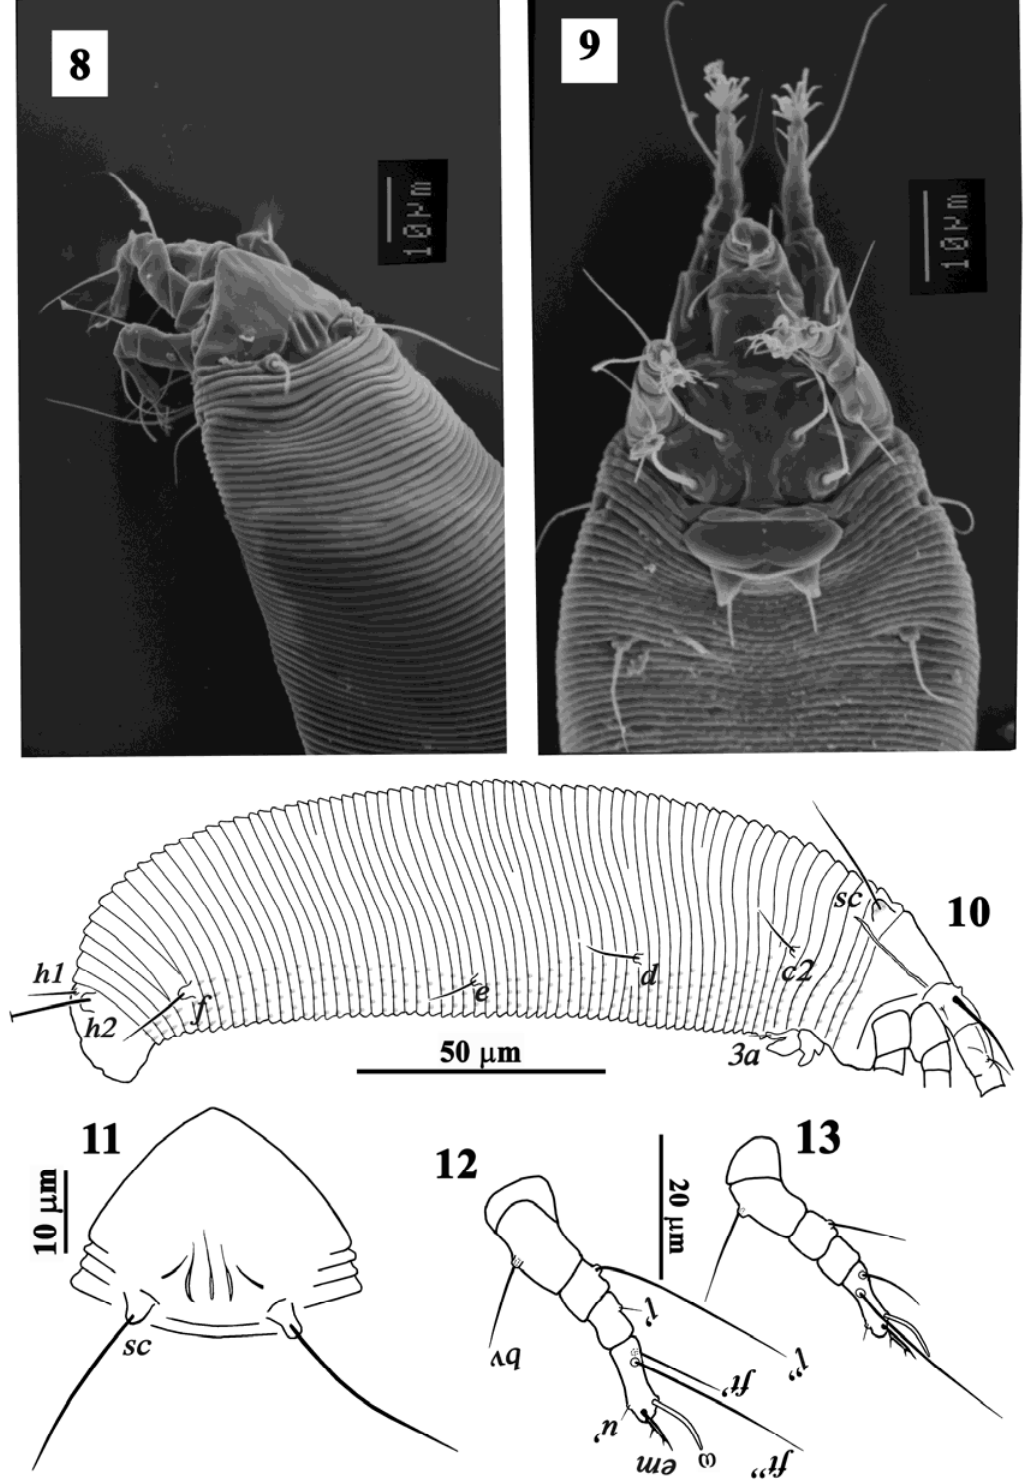
F IGURES 8-13. A. tristriatus (Nalepa) (Female deutogyne): 8. Dorsal view of deutogyne; 9. Ventral view of deutogyne; 10. Lateral view of deutogyne; 11. Prodorsal shield; 12. Leg I; 13. Leg